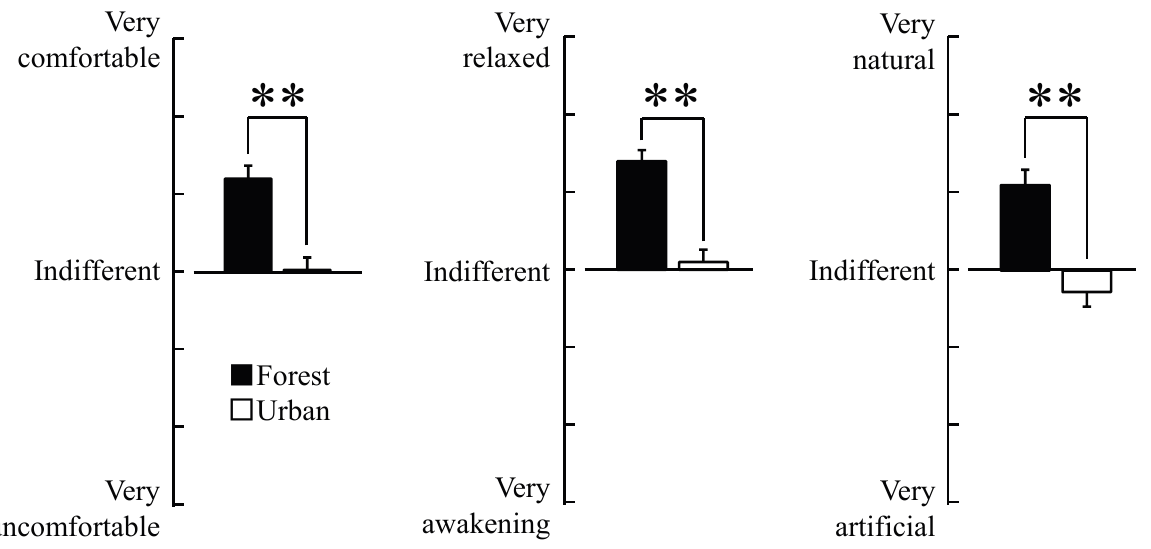
Figure 4. Comparison of “comfortable,” “relaxed,” and “natural” feeling scores between the two environments. N = 20, mean ± standard error. ** p < 0.01, Wilcoxon signed-rank